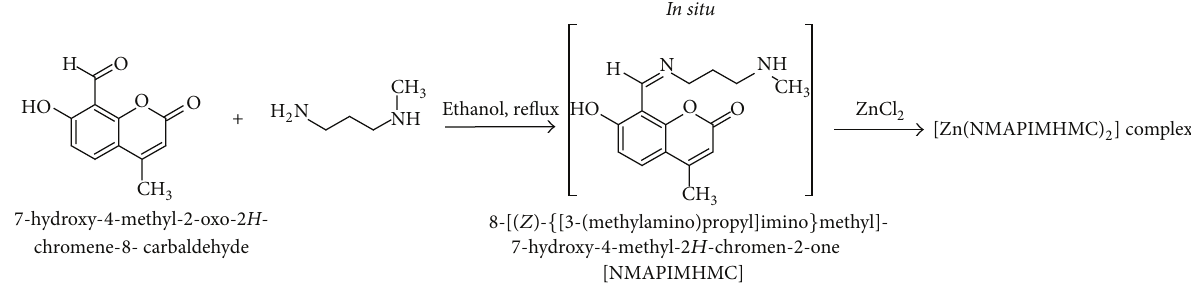
Scheme 2: Synthesis of Zn(II) complex of Schiff base 7-hydroxy-4-methyl-8-[( Z )- { [3-(methylamino)propyl]imino } methyl]-2 H -chromen-2- one